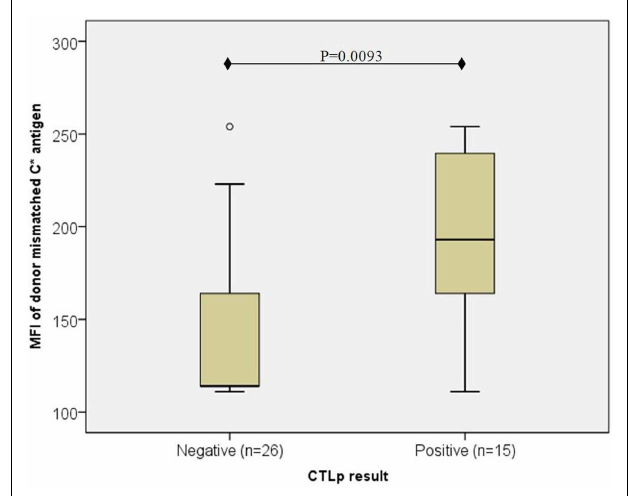
FIGURE 2 |Association of donor mismatched C antigen cell surface expression with CTLp result in cases where the recipient’s antigen is of low expression ( < 115) .The median MFI of the donor’s mismatched HLA-C cell surface expression level was lower in CTLp negative cases than in CTLp positive cases ( p = 0.0093, MWU test) among pairs where the recipient’s HLA-C expression level of the mismatched allele was low (MFI < 115). Horizontal line represents median MFI, box plot represents MFI values between the 25th and 75th percentiles, and thin whiskers represent range.